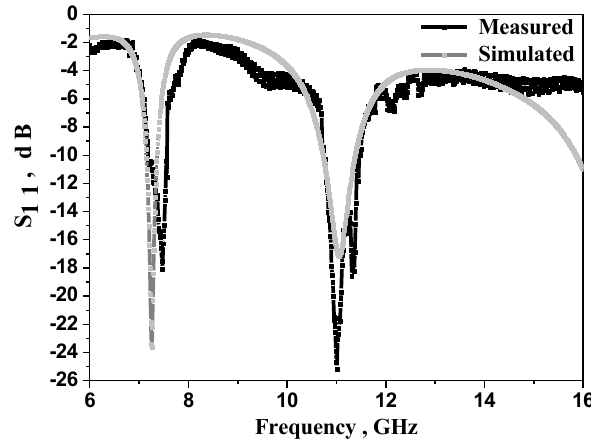
Fig.9. Comparison between the simulated and measured S 11 of the proposed